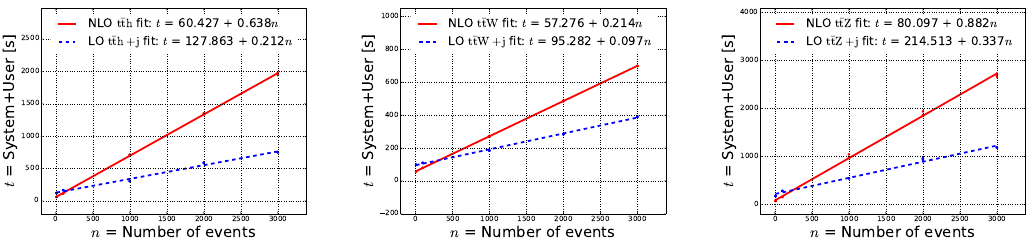
Figure 13 . Plots showing how the CPU time scales with the number of events generated for the NLO and LO models. For t¯th (left), the slope of the fit to the NLO points is about 3 times larger than the slope of the line fit to the LO points. For t¯tW (center), the slope of the fit the NLO points is about 2 times larger than the slope of the line fit to the LO points. For t¯tZ (right), the slope of the line fit to the NLO points is about 3 times larger than the slope of the line fit to the LO points. For consistency with the NLO samples, the LO samples were generated with a QED=1